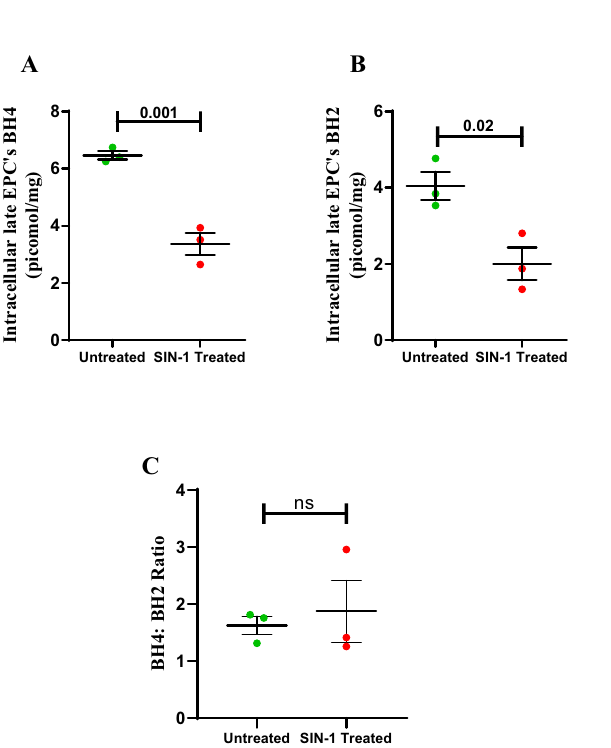
Figure 10. Effect of in vitro SIN-1 treatment on intracellular ECFC’s BH4, BH2 and BH4:BH2. Dot plot represents ( A ) intracellular ECFC’s BH4 ( B ) intracellular ECFC’s BH2 ( C ) BH4/BH2 ratio in untreated and SIN-1 treated groups with individual data points and error bars (n = 3 for each group). Significance was assessed by student ttest and data is represented as mean ± SE. Error bar represent standard error of mean; dots represent average values of the parameters obtained from experimental duplicates p < 0.05 was considered statistically